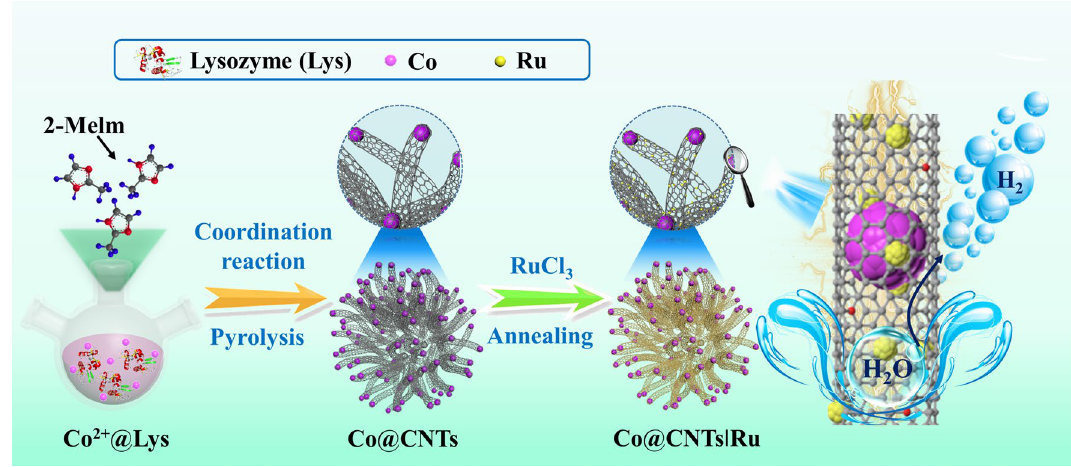
Fig. 1 Synthetic procedure for the preparation of Co@CNTs|Ru